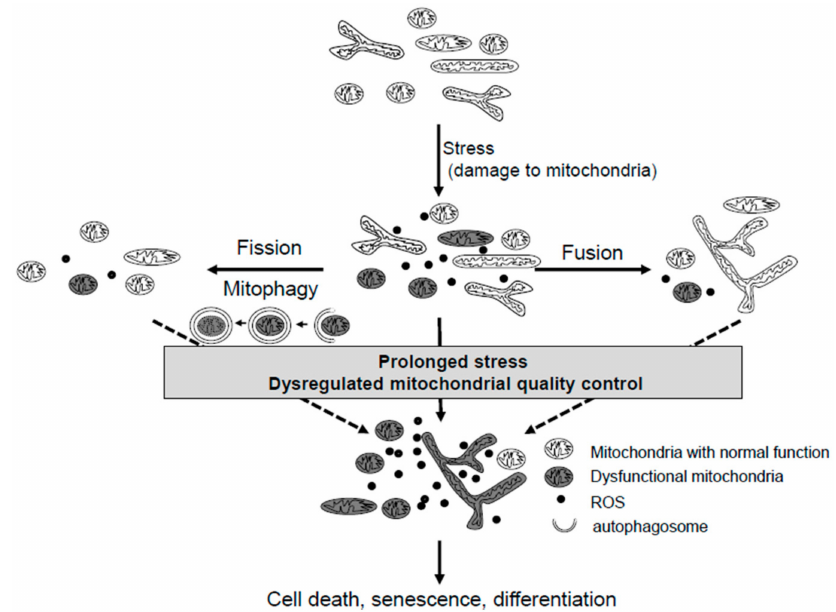
Figure 1. The mitochondrial quality control systems in cells. Under mild stress, mitochondrial fusion dilutes the damage of dysfunctional mitochondria, or fission leads to the segregation and removal of damaged mitochondria by mitophagy. However, if the stresses are severe and prolonged or if the mitochondrial quality control systems are dysregulated, these adaptive responses are overwhelmed by the stress, affecting the cell